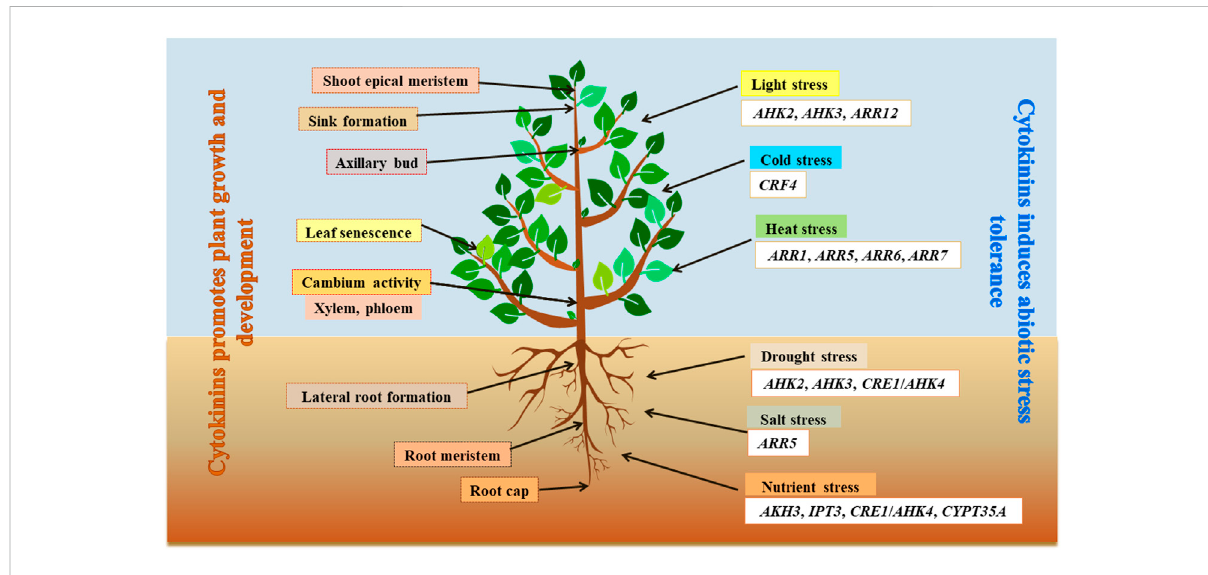
FIGURE 3 Cytokinins function in plant development and abiotic stress. Schematic illustration of cytokinin as a signaling molecule that regulates key plant developmental processes and its response to various abiotic